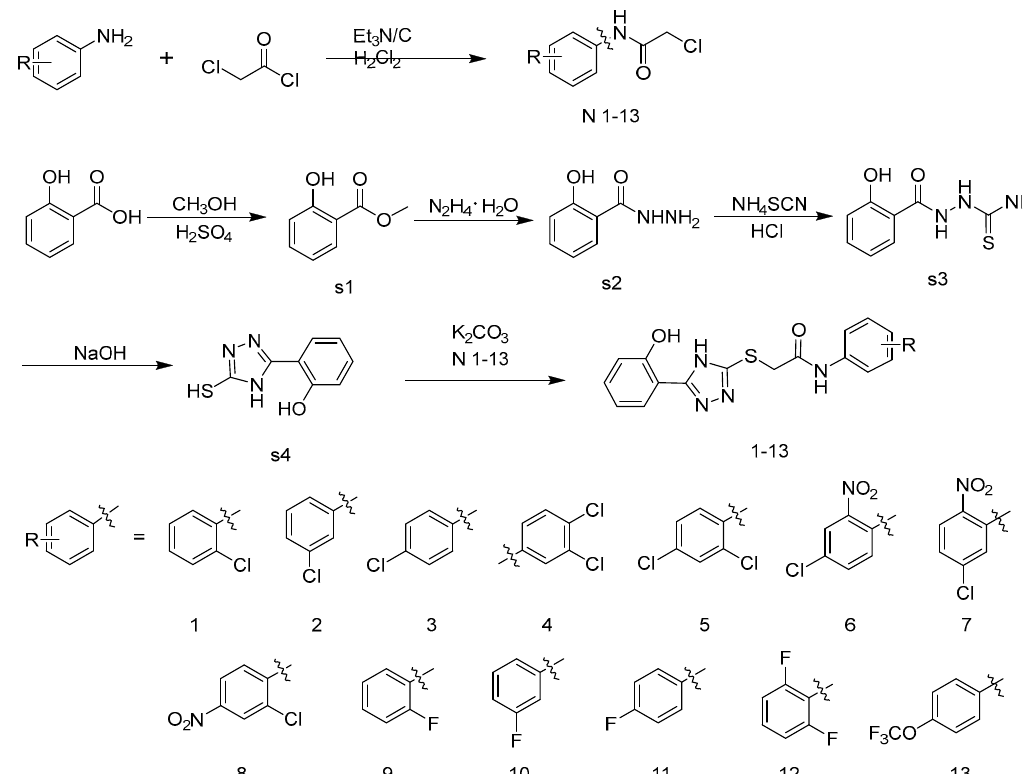
Scheme 1. Synthetic route of halogen-substituted